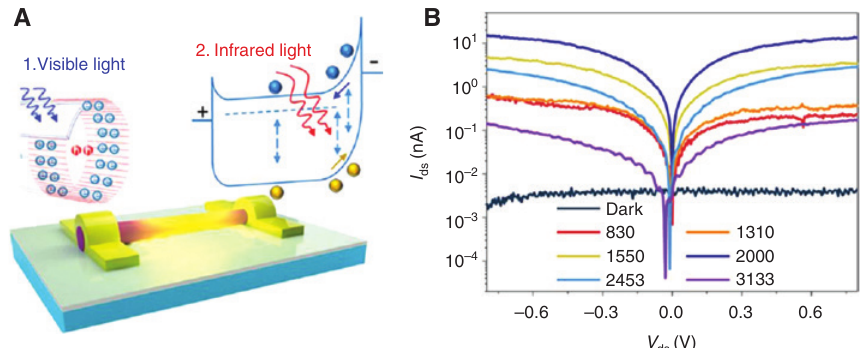
Figure 6: Schottky Ohmic contacted InAs NW photodetectors. (A) Schematic of InAs Photoconductor NW operating at visible to NIR regime. (B) The IV characteristics under different illumination wave- lengths at the same power density (0.75 mW/mm 2 )